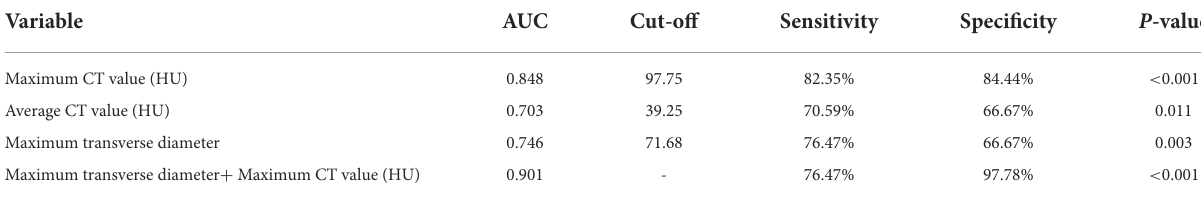
TABLE 5 Clinical variables predict the area under the ROC curve for RAAA.